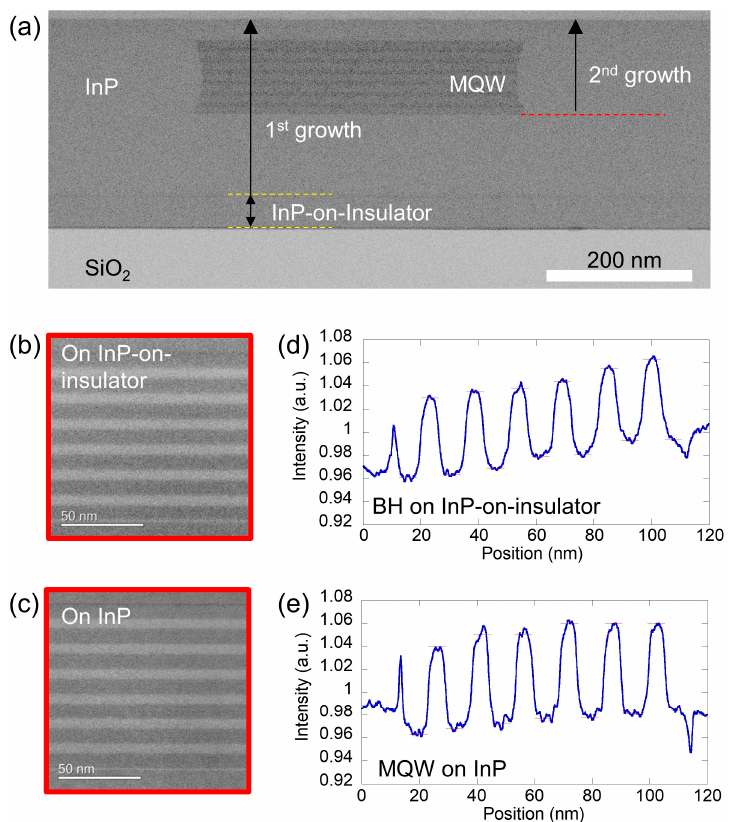
Figure 7. ( a ) Cross ‐ sectional bright ‐ field scanning transmission electron microscope (BF ‐ STEM) image of BH on Si substrate; ( b , c ) high ‐ angle annular dark ‐ field (HAADF) ‐ STEM image of MQW ‐ BH grown on InP ‐ on ‐ insulator substrate and MQW grown on InP substrate; ( d , e ) moving average of contrast profile extracted from HAADF ‐ STEM images.